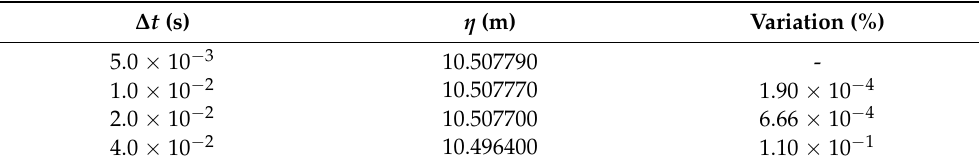
Table 6. Free surface elevation height at x = 50.00 m and t = 15.00 s and the variation among the time